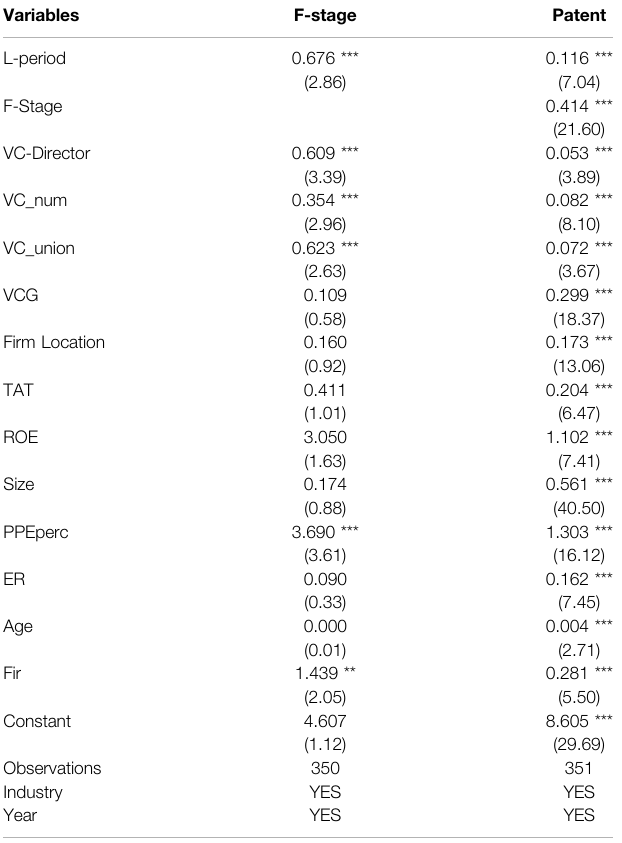
TABLE 11 | Regression results of testing the mediating effect of phased strategies. Variables